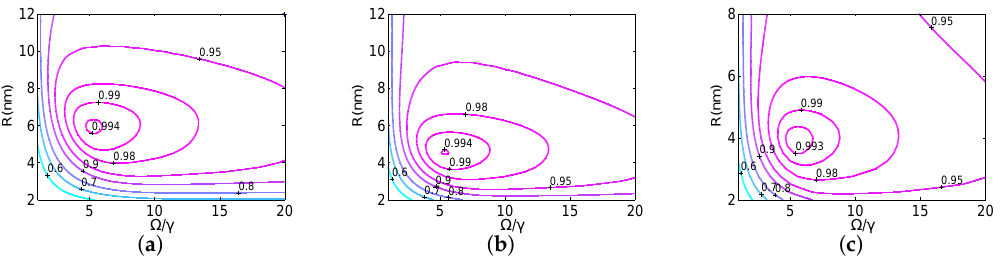
Figure 5. Contours of ρ 22 ( T ) for duration T = 2/ γ = 1.097 ns versus the distance R between the QD-monolayer and the Rabi frequency Ω , for the bad quality MoS 2 and three values of the host dielectric permittivity, ( a ) (cid:101) 1 = 2, ( b ) (cid:101) 1 = 4, and ( c ) (cid:101) 1 = 6. Observe that similar levels of fidelity are obtained with the case where the host medium is taken to be the free-space vacuum ( (cid:101) 1 = 1), although they are slightly reduced with increasing permittivity. Specifically, the maximum fidelities for the three displayed cases with (cid:101) 1 = 2,4,6 are 0.9943,0.9941,0.9939, respectively. Table 1. Optimal Purcell factors related to the three cases marked by red stars in the second column of Figure 3, where the final time is T = 2/ γ = 1.097 ns: good quality MoS 2 layer at R = 3.5 nm, medium quality MoS 2 layer at R = 6 nm, and bad quality MoS 2 layer at R = 7.5 nm. Purcell factors Good Medium Bad F x 4.64435 4.72492 4.73458 F z 8.23301